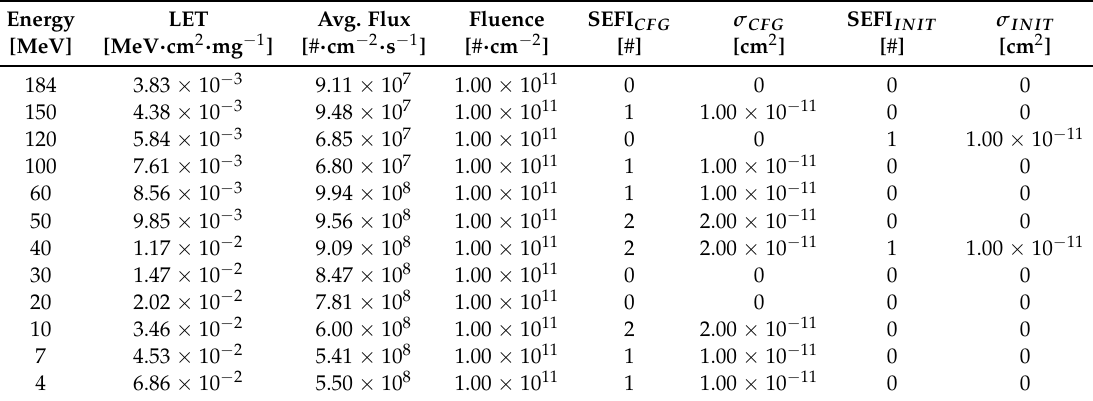
Table 9. SEFI rate for DUT Sample 1.